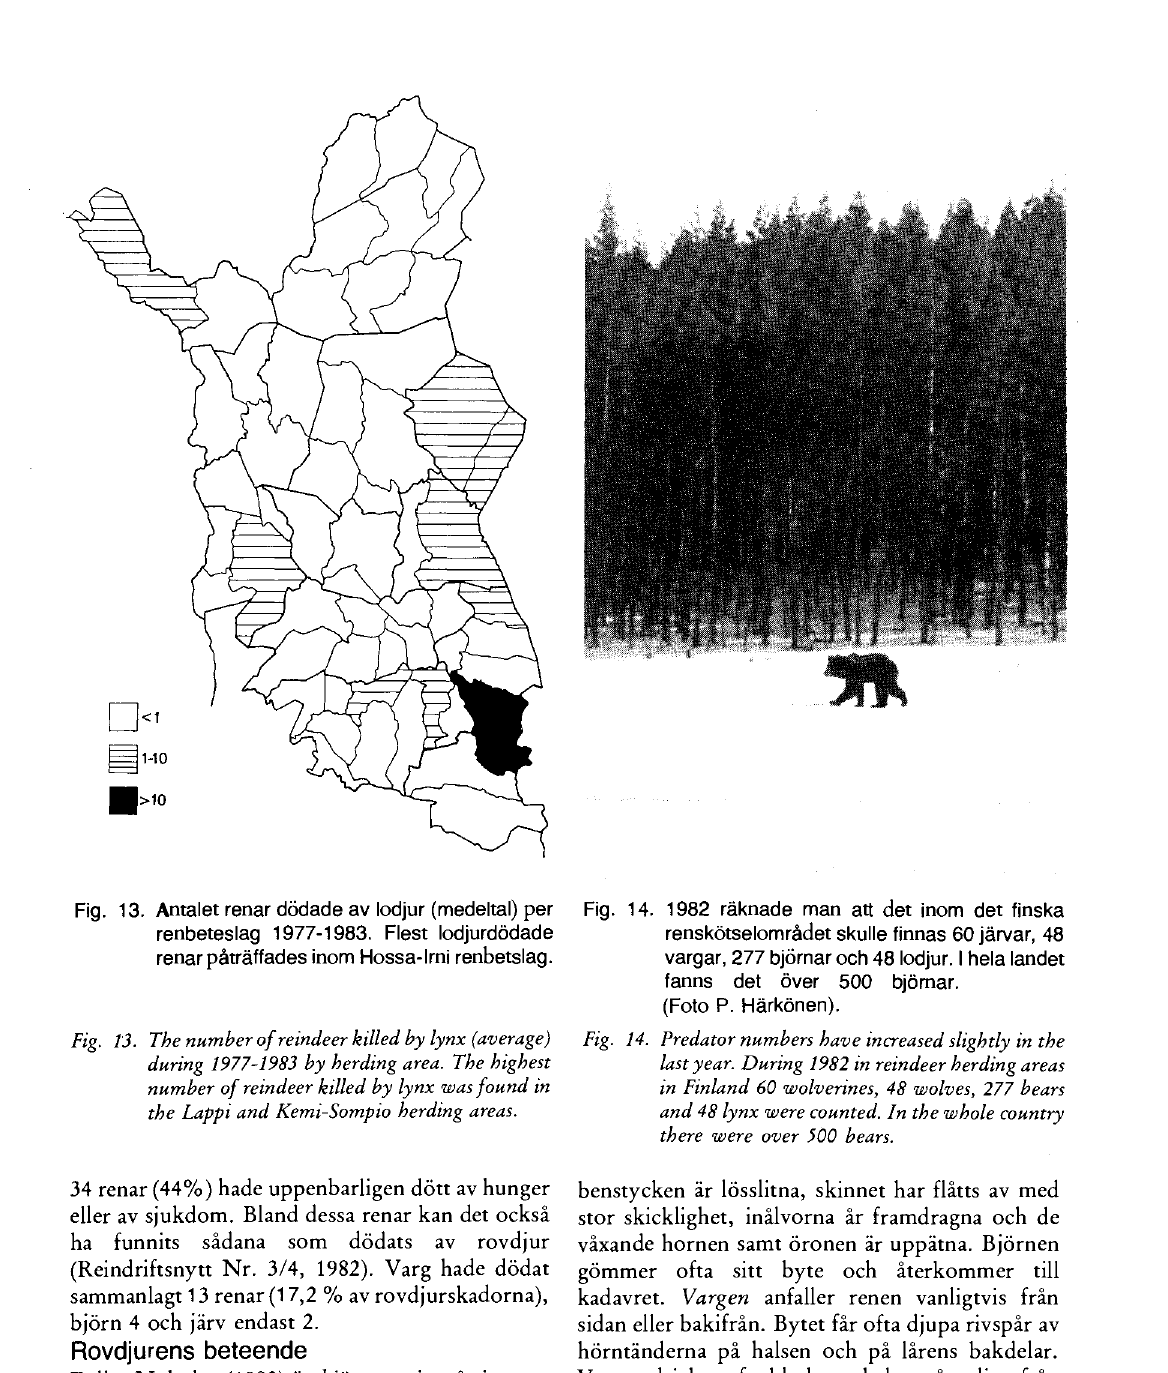
Fig. 13. Antalet renar dödade av lodjur (medeltal) per renbeteslag 1977-1983. Flest lodjurdödade renar påtraffades inom Hossa-lrni renbetslag. Fig. 13. The number of reindeer killed by lynx (average) during 1977-1983 by herding area. The highest number of reindeer killed by lynx was found in the Lappi and Kemi-Sompio herding areas. 34 renar (44%) hade uppenbarligen dott av hunger